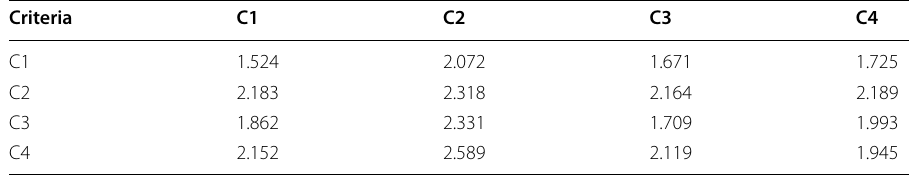
Table 21 Total relation matrix for revenue sharing model